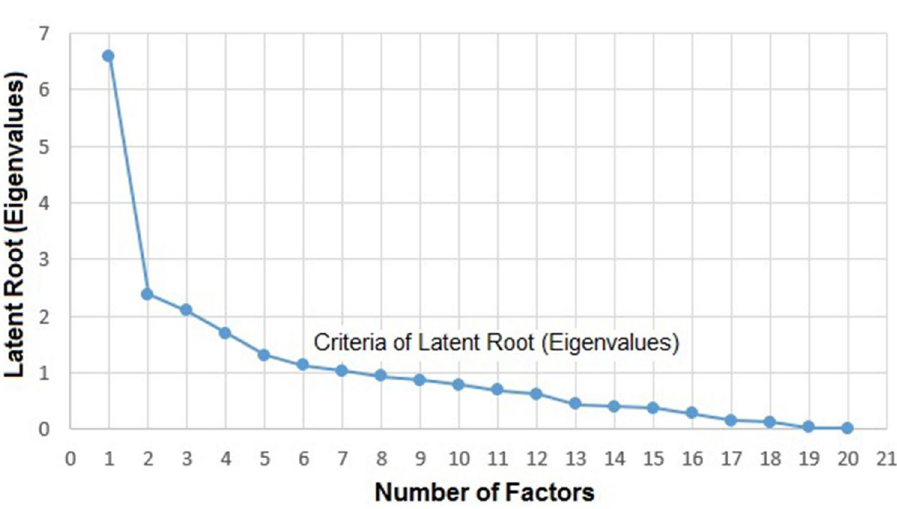
Figure 2. Screen test indicating the number of factors to be extract, using Excel, version 15.0 117